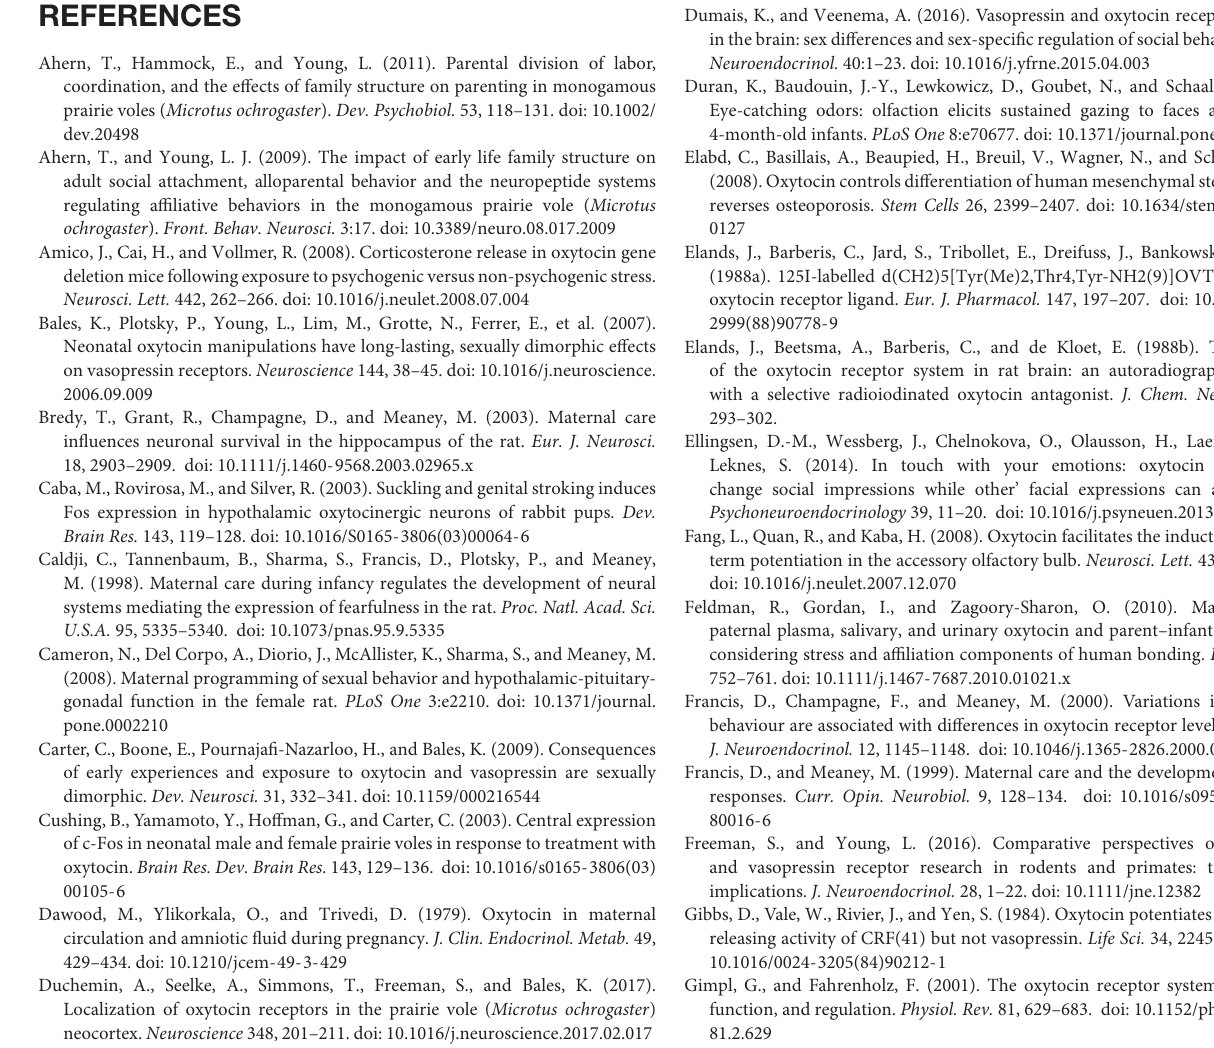
TABLE S1 | OXTR ligand binding density measurements in tissue sections after exposure to 0.05 nM radioactive ligand in male and female neonatal prairie voles competed with 0 nM or 1000 nM OXT. Net values represent the difference between 0 nM and 1000 nM competition and are used to demonstrate ligand